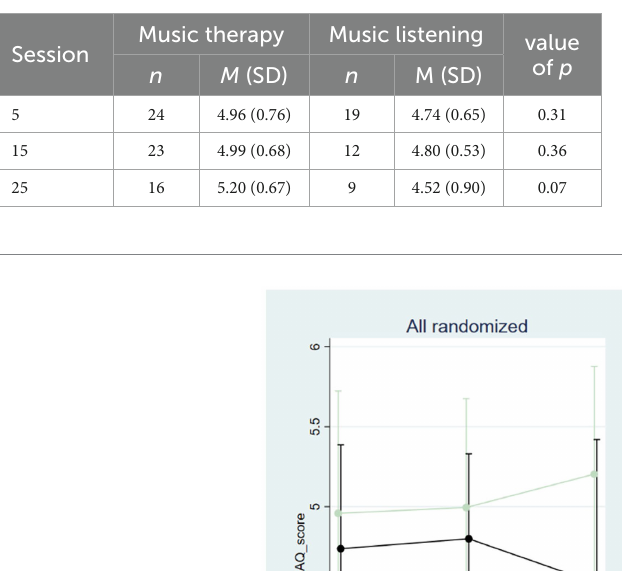
TABLE 2 Helping alliance (Haq-II) scores in each intervention.